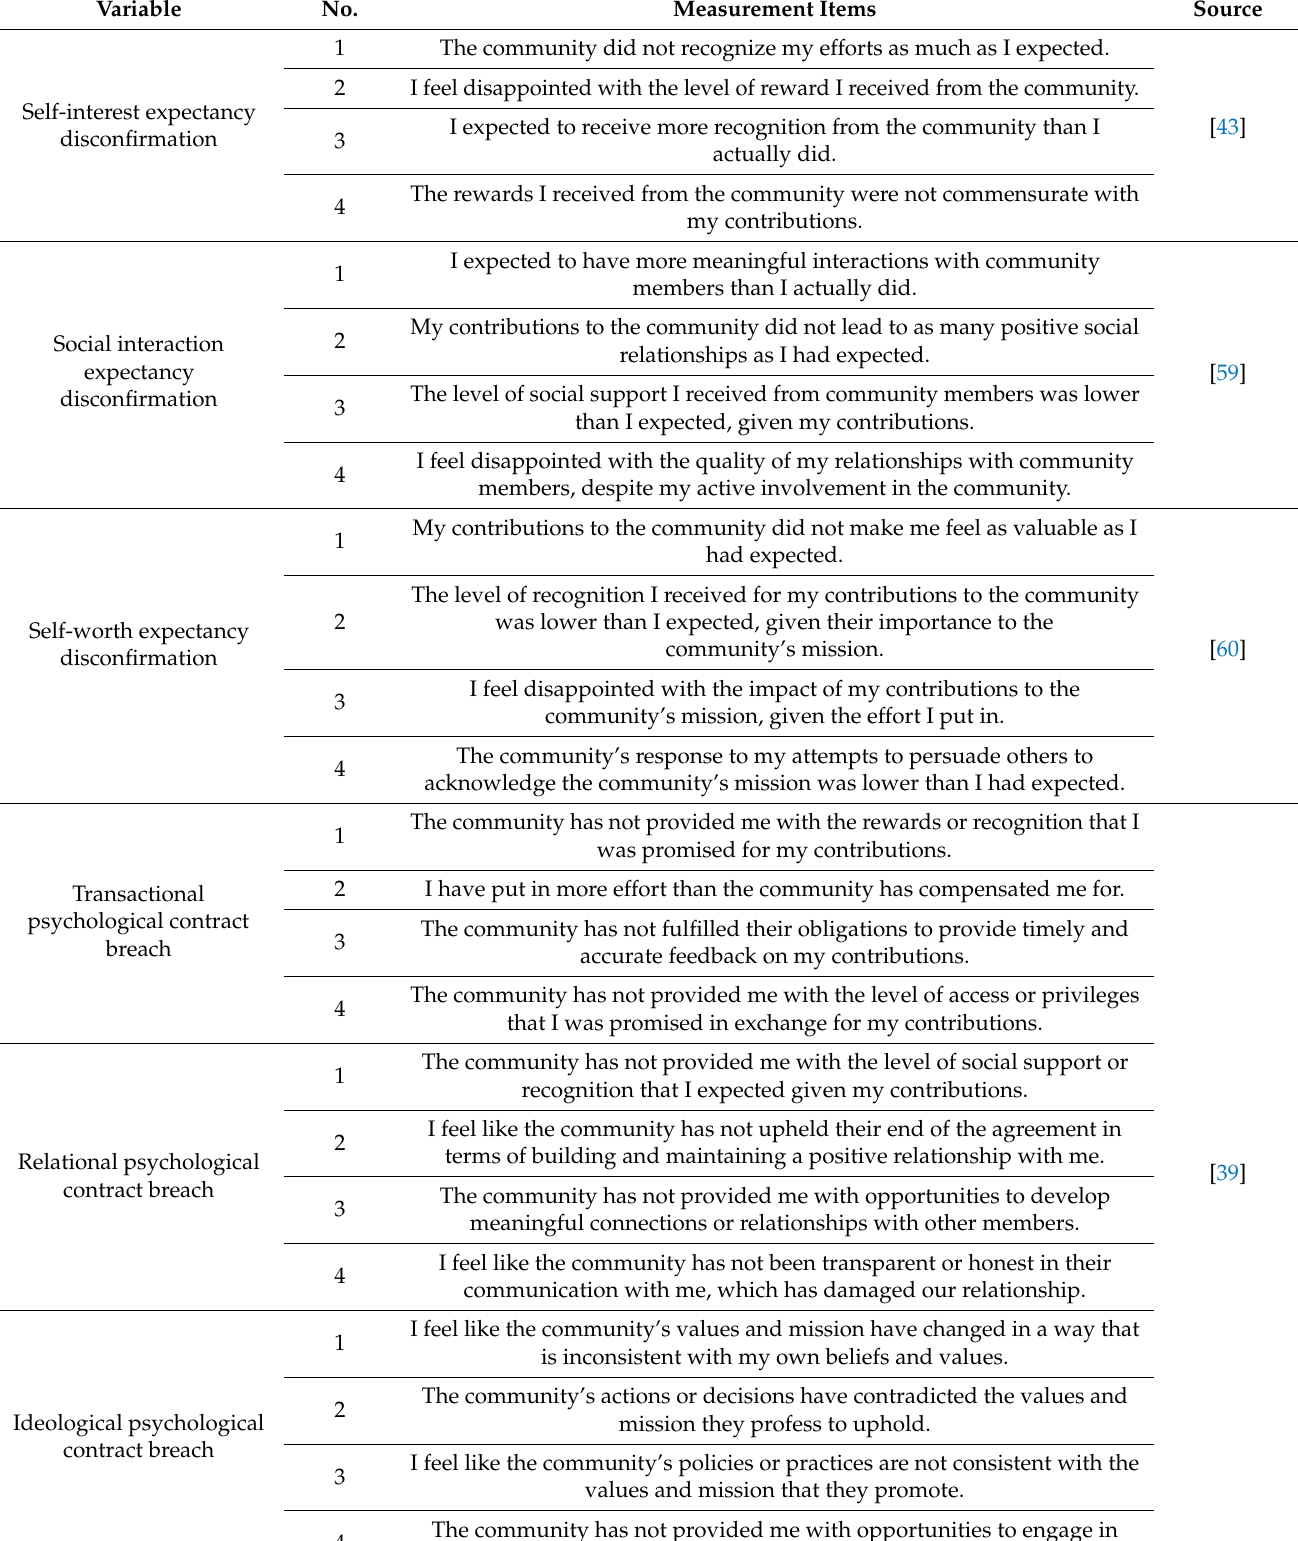
Table 2. Study variables and corresponding scale items used in the